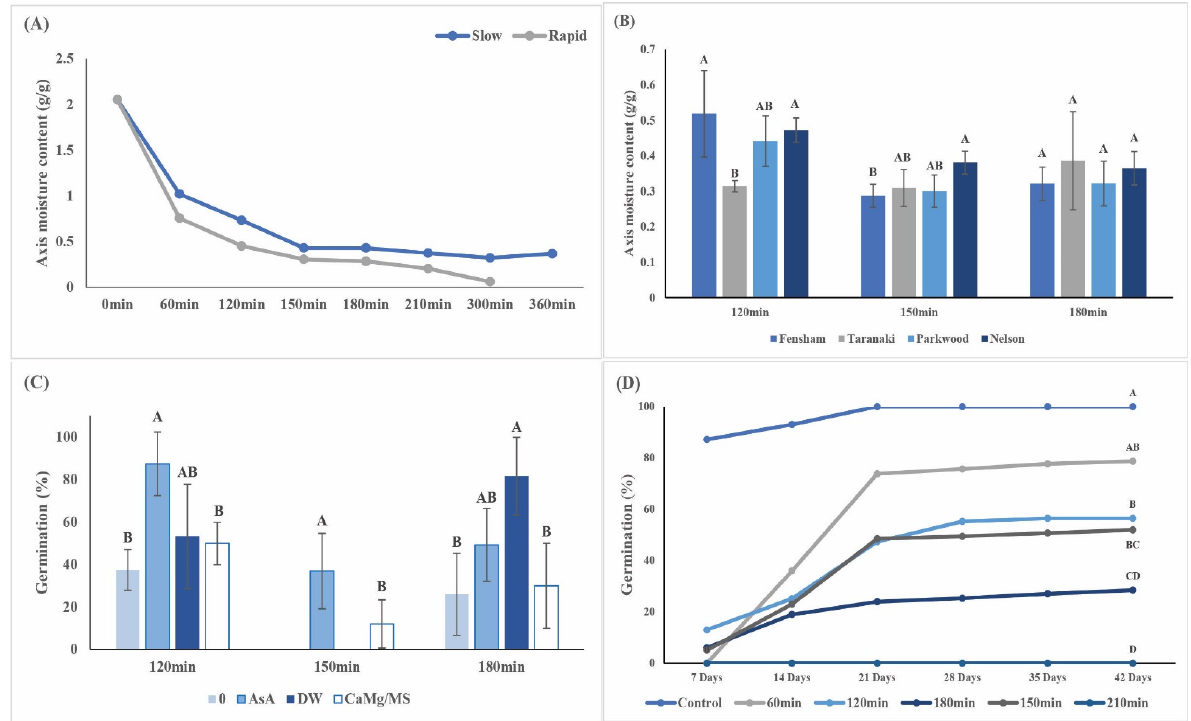
Figure 2. Comparative moisture loss from embryonic axes (EAs) was significantly faster during rapid desiccation ( A ). Each datum point is the mean of 40 individual EAs. Significant differences in moisture loss between seed lots were recorded during rapid desiccation for 120 min and 150 min, but moisture contents were similar after 180 min ( B ). Rehydration with ascorbic acid (AsA) improved embryo survival following rapid desiccation for 120 and 150 min ( C ). Rapid desiccation delayed the onset of radicle emergence (indicating survival) across all desiccation treatments, with final survival significantly lower for longer desiccation treatments ( D ). Letters above bars and line graphs for each desiccation treatment indicate significant differences at p < 0.05 based on Tukey’s HSD. Error bars represent the SD of the mean.